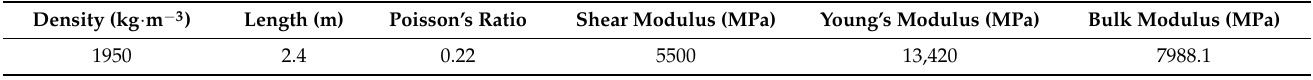
Table 1. The parameters of the wind turbine blade (WTB).